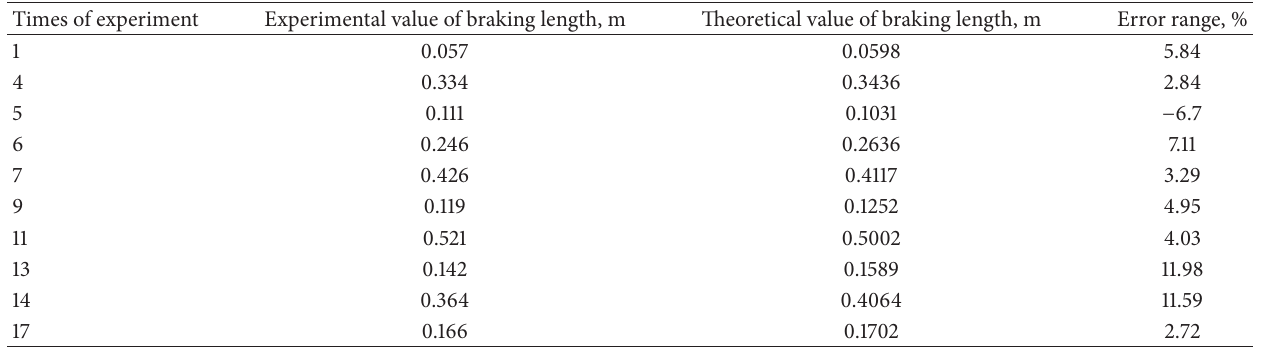
2.72%, respectively. But the error is reasonable because of braking length and the energy absorber are